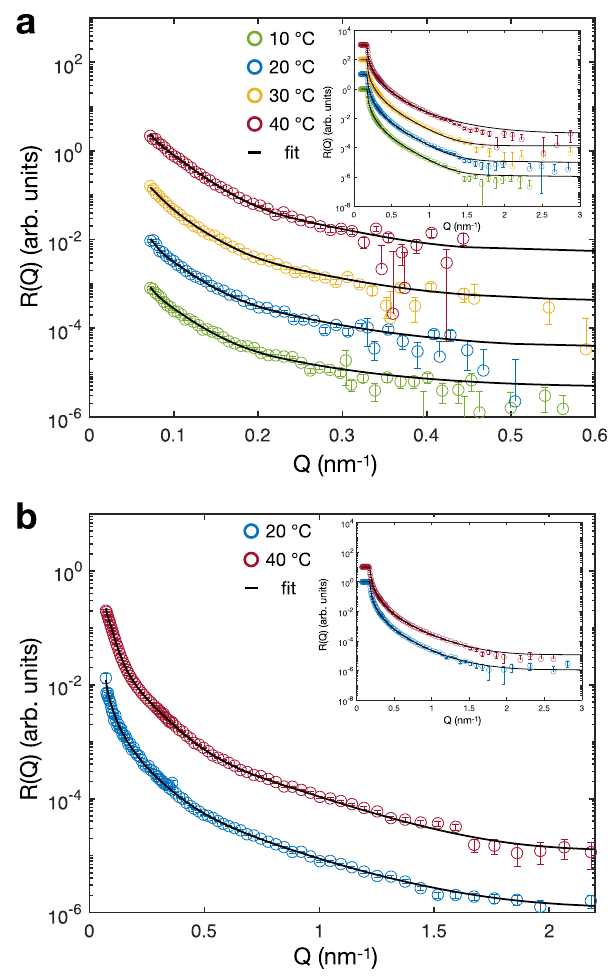
Fig. 1 Re fl ectivity curves of 5 mol% cross-linked microgels at different temperatures. a Re fl ectivity, R(Q), versus momentum transfer, Q , of pNIPAM microgels at the air-ACMW interface and corresponding fi ts. b Re fl ectivity curves of D7-NIPAM microgels at the air-ACMW interface with fi ts. Insets: Re fl ectivity curves at air-D 2 O interfaces. The curves are shifted in y-direction for clarity. The unshifted curves are shown in Supplementary Fig. 6a, b. The error bars represent the statistical errors on